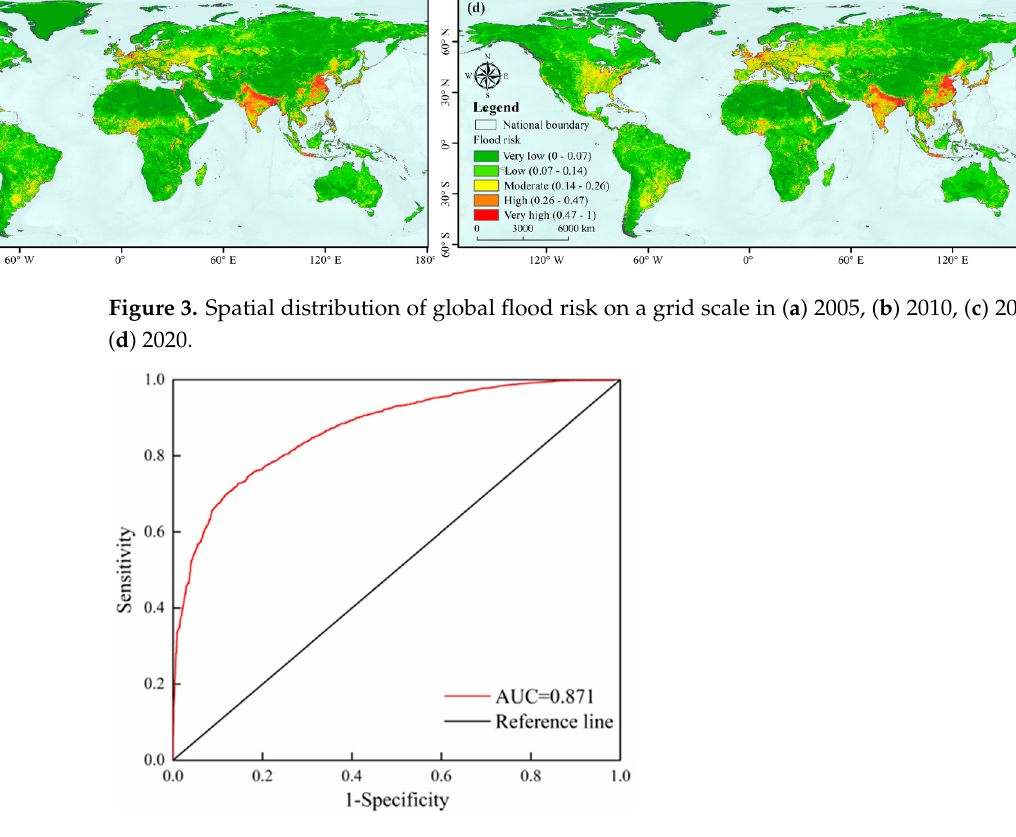
Figure 4. Validation of GT model.